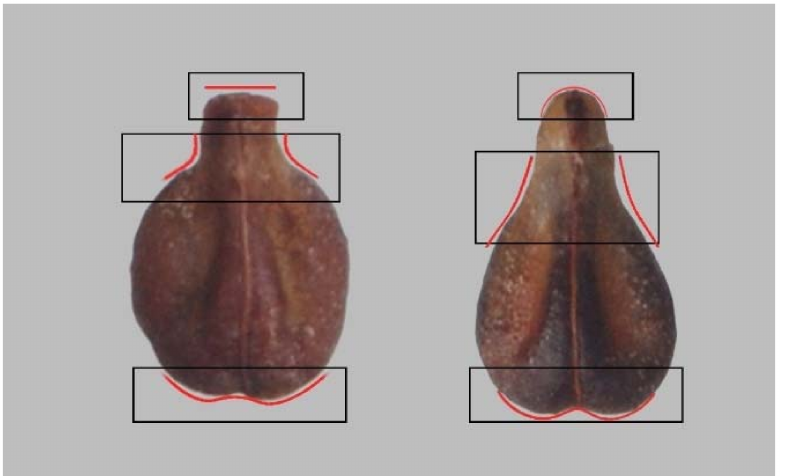
Figure 1. Seeds of the cultivars Albillo Real ( left ) and Air é n ( right ) showing the regions observed for modelling. The variable regions are indicated with rectangles and correspond to the upper and lateral edges of the peduncle, and to the curvature at the base. The red lines show the variations in these regions corresponding to a flat peduncle in Albillo Real, in contrast to a rounded top in Air é n. The peduncle appears more differentiated from the rest of the seed in Albillo Real, while there is more continuity in Air é n. The discontinuity at the base is more pronounced in the Air é n seed, on the